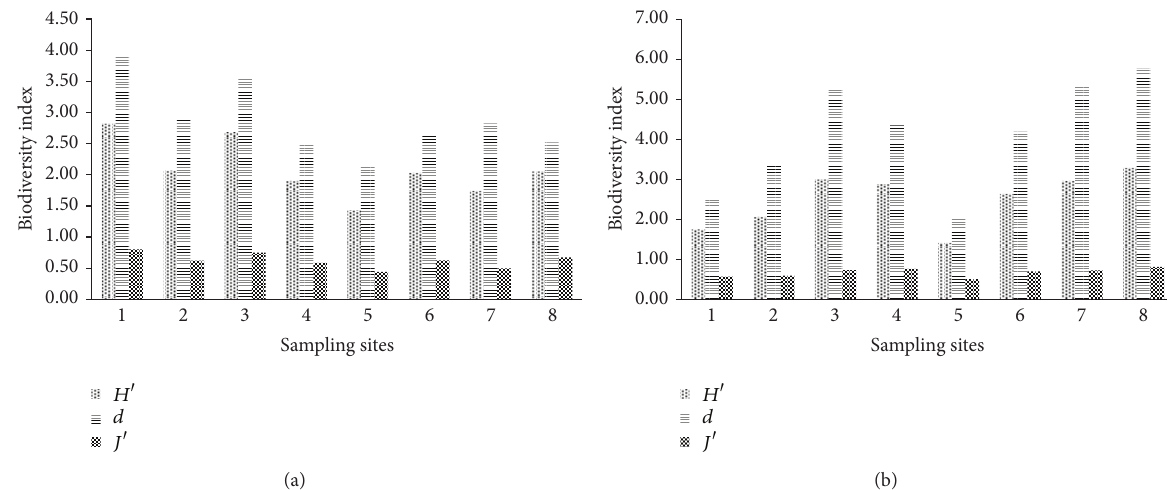
Figure 3: Biodiversity index of the phytoplankton in different sampling sites in Baiyangdian Lake in spring (a) and summer (b).